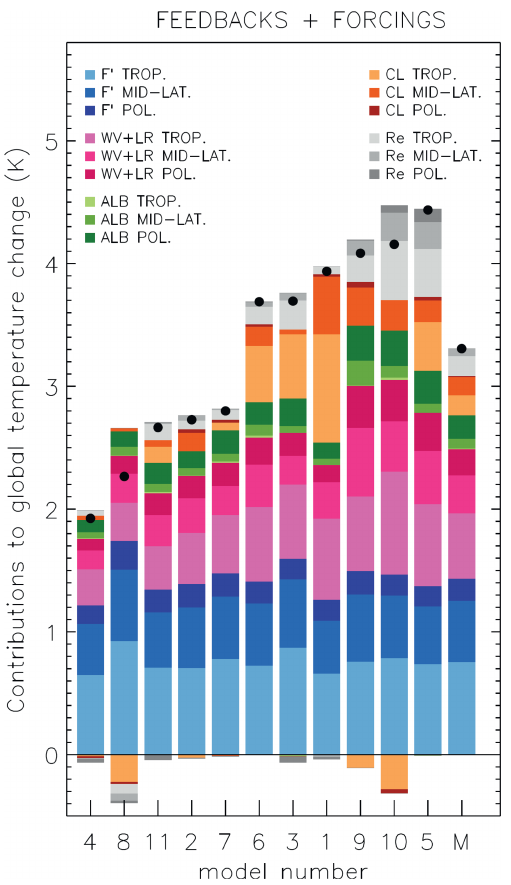
Figure 17. Climate sensitivity estimates (for equilibrium at CO 2 doubling as given by the black dots) associated with the Planck response to the stratosphere-adjusted forcing and the adjustments ( F (cid:48) ), feedbacks (“classical feedbacks”), and forcings for 11 differ- ent ESMs according to Vial et al. (2013). The colours’ hue denotes the regional range (tropical, mid-latitude, and polar). F (cid:48) denotes the Planck response to stratosphere-adjusted forcing and other ad- justments to CO 2 forcing and land surface warming, WV + LR de- notes the combined water vapour and lapse rate feedback, ALB the albedo feedback, and CK the cloud (CL) feedbacks. Re is the feedback residual term. The numbers denote the following models: (1) IPSL-CM5A-LR; (2) NorESM1-M; (3) MPI-ESM-LR; (4) INMCM4; (5) HadGEM2-ES; (6) CanESM2; (7) MIROC5; (8) CCSM4; (9) BNU-ESM; (10) FGOALS-s2; and (11) MRI- CGCM3. For details, see the original source: Vial et al. (2013) and Fig. 5b therein. Reprinted by permission from: Springer, Climate Dynamics, Vial, J., et al., On the interpretation of inter-model spread in CMIP5 climate sensitivity estimates, 41, 3339–3362, ©Springer